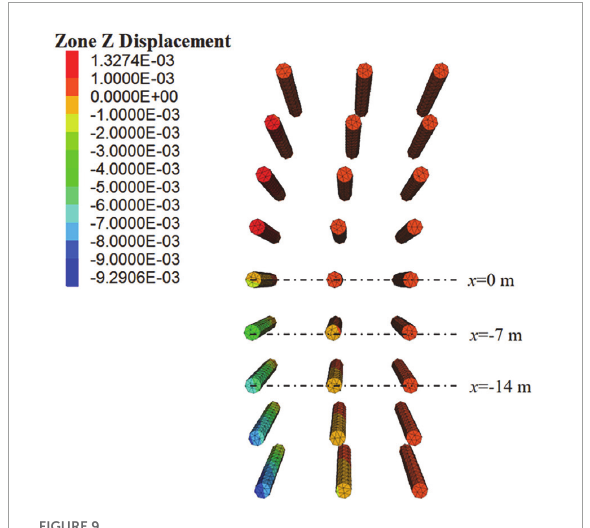
FIGURE9 Pile foundation settlement cloud